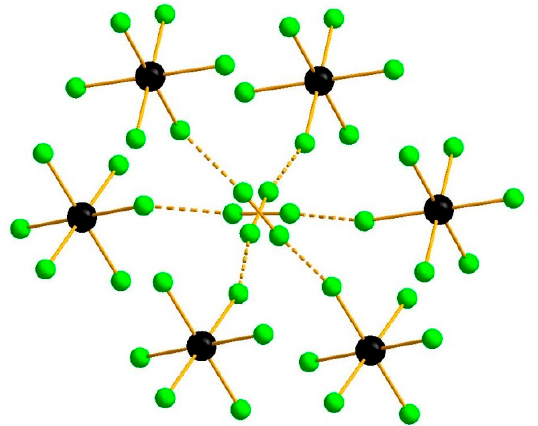
Figure 1. Cl ··· Cl interactions (dashed) in the structures of 1 and 2 . Metal: black, Cl: light green.